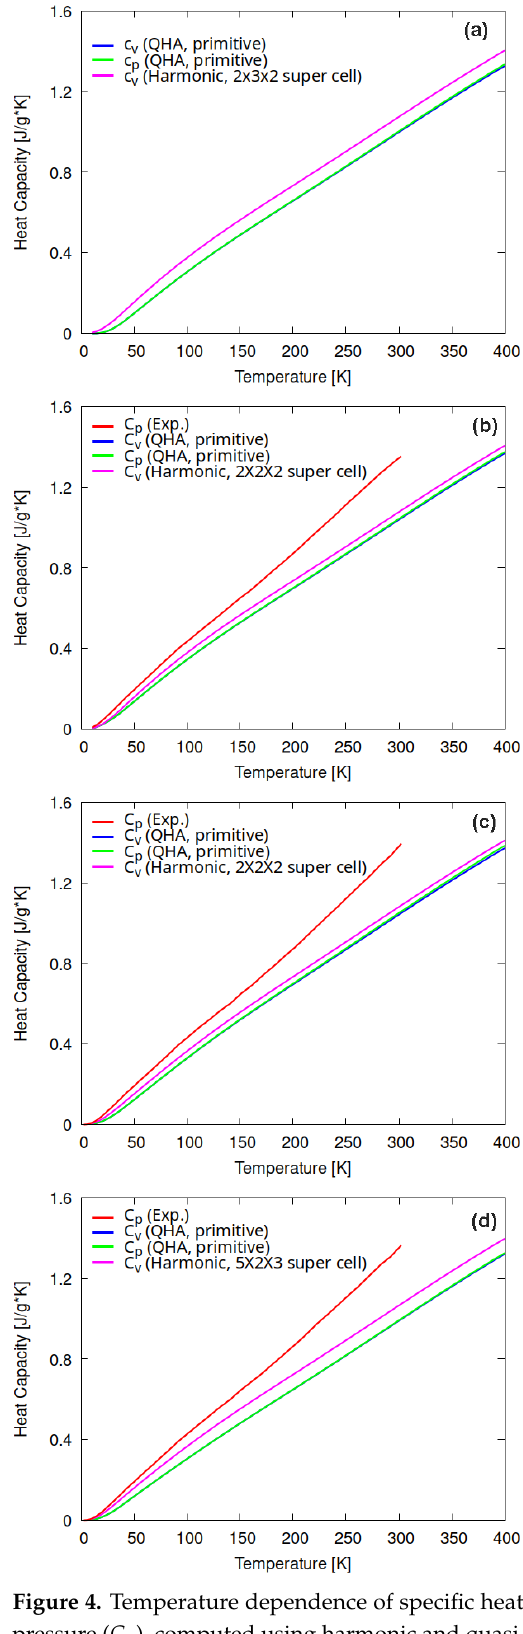
Figure 4. Temperature dependence of specific heat capacity at constant volume ( C v ) and constant pressure ( C p ), computed using harmonic and quasi-harmonic approximation for ( a ) cellulose I α , ( b ) cellulose I β , ( c ) cellulose II, and ( d ) cellulose III 1 . Available experimental data are also plotted